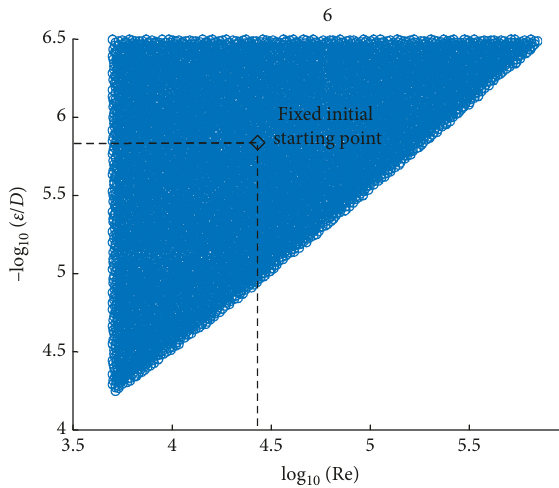
8 regarding the “traditional” option for the starting point calculated −